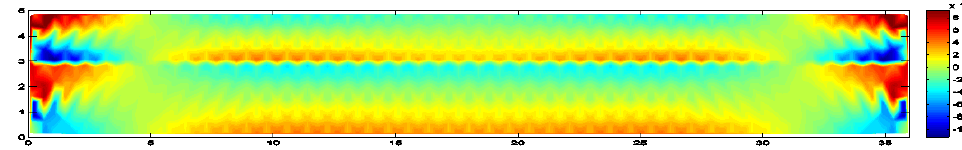
Figure 13. The contour of 𝜎 𝑥 of the lower beam by the G- α 0 method.